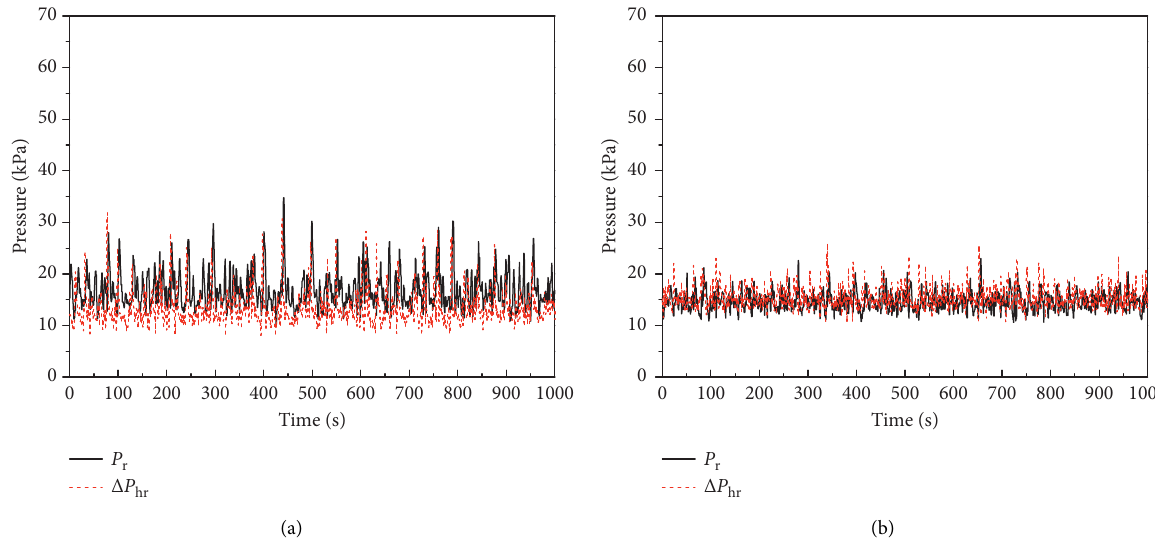
Figure 9: Pressure of P r and Δ P hr for irregular-stable flow (a) and regular-stable flow